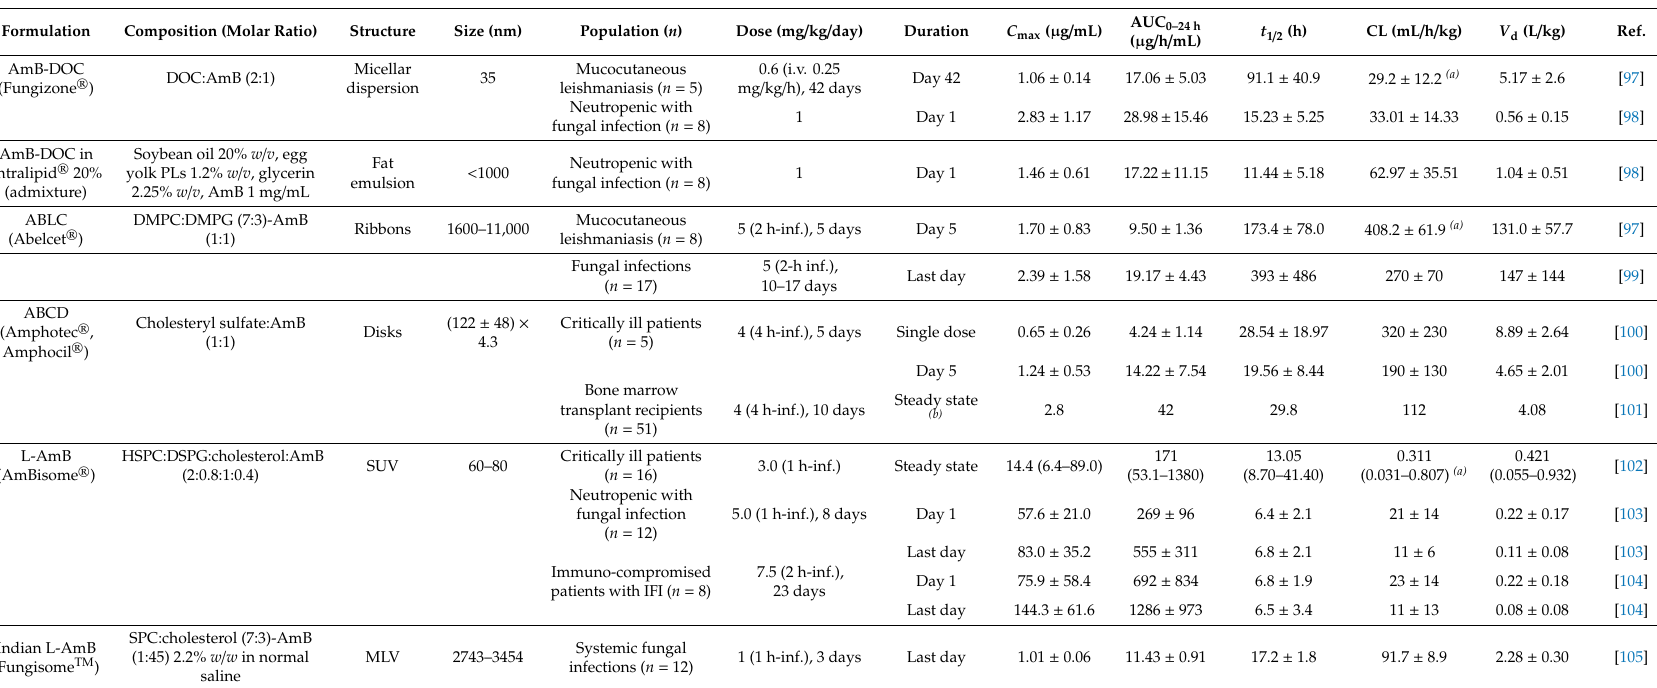
Table 1. Properties and clinical pharmacokinetic parameters of commercial amphotericin B parenteral formulations.